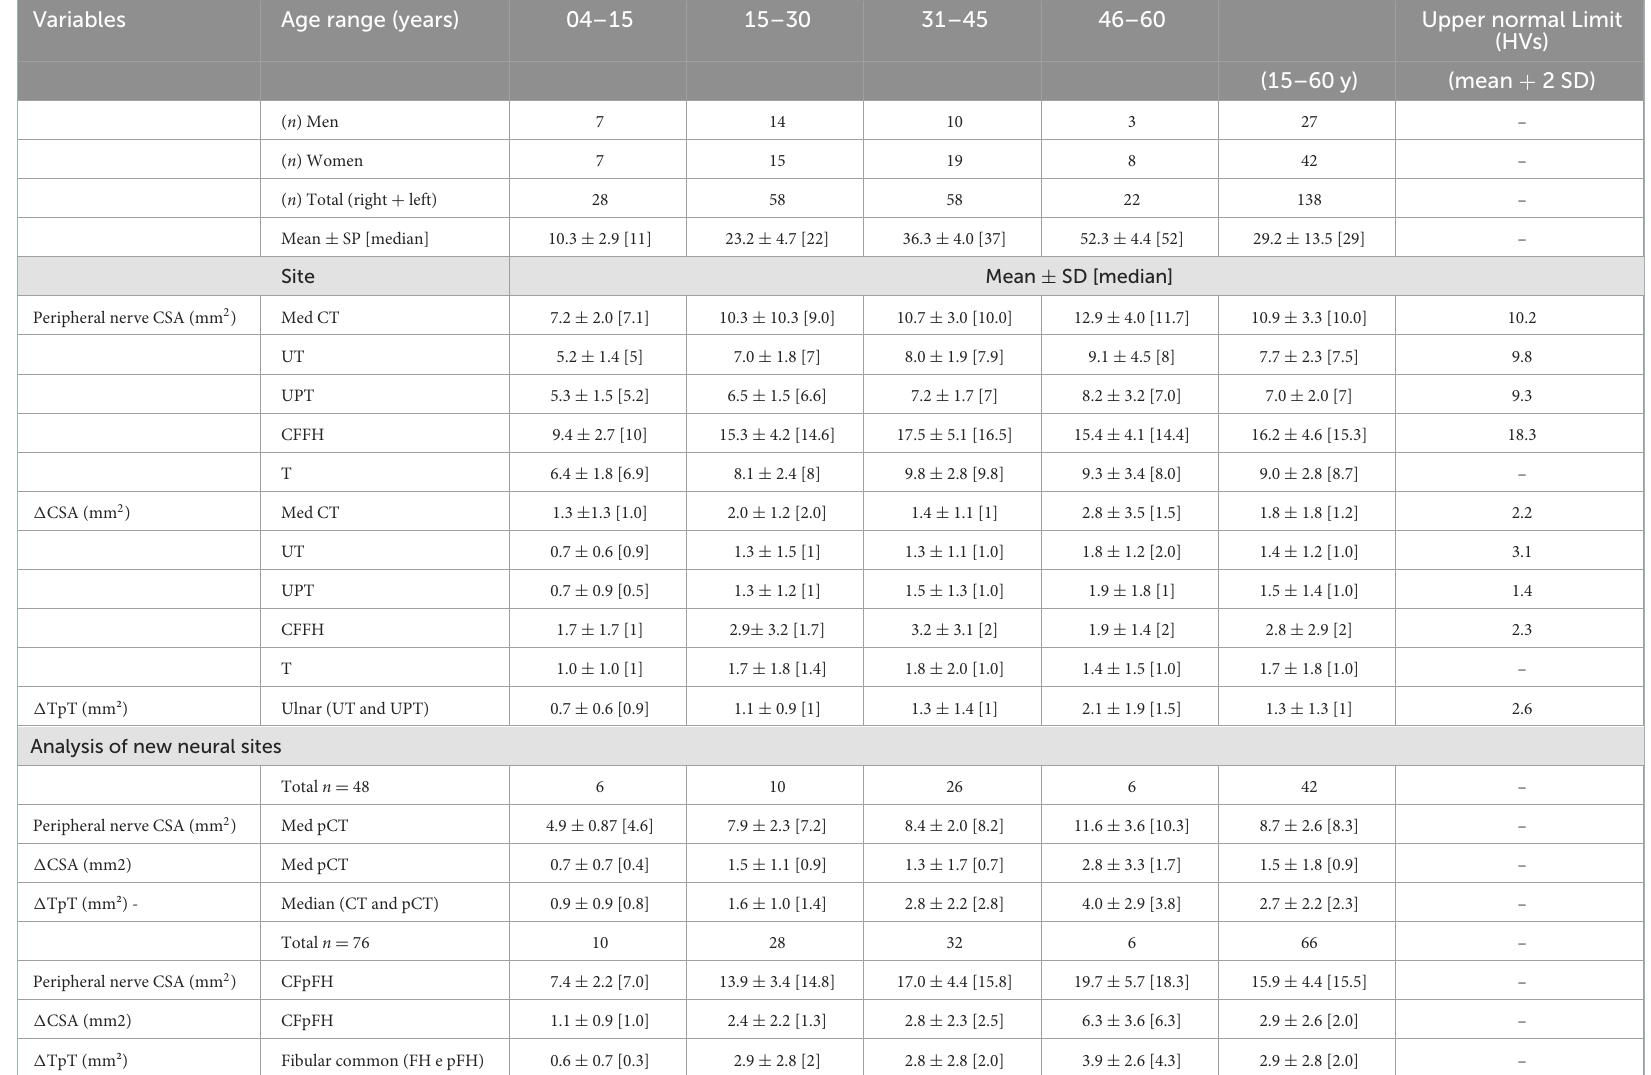
TABLE 2 Distribution of ultrasound measurements (CSA, 1 CSA, 1 TpT) according to age range in HHCs and upper normal limit in HVs.